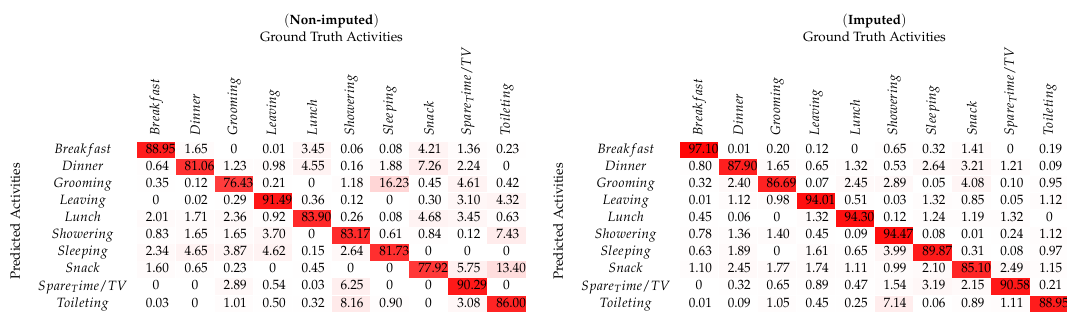
Table 5. Confusion matrix for per-class HAR using non-imputed & imputed UCI-ADL (OrdóñezB) dataset.